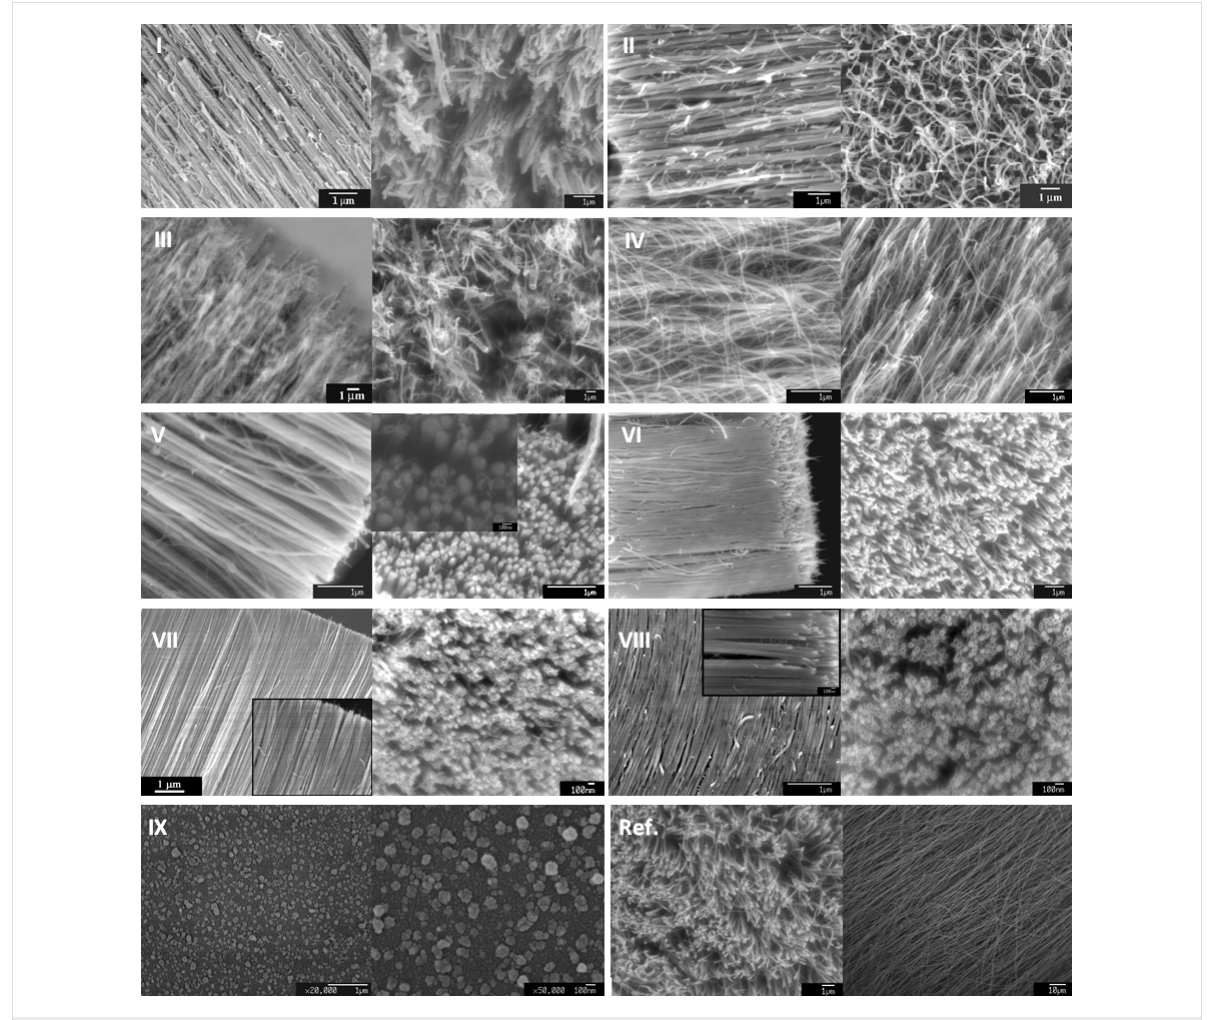
Figure 3: SEM examination of the N-CNTs from Syntheses I–IX and MWCNT from Ref. Synthesis .